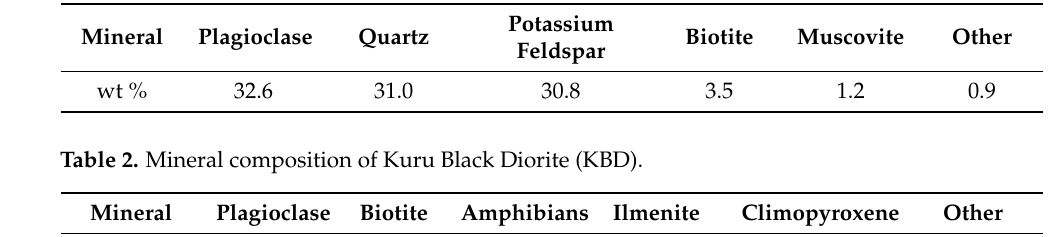
Table 1. Mineral composition of Kuru Grey Granite (KGG).